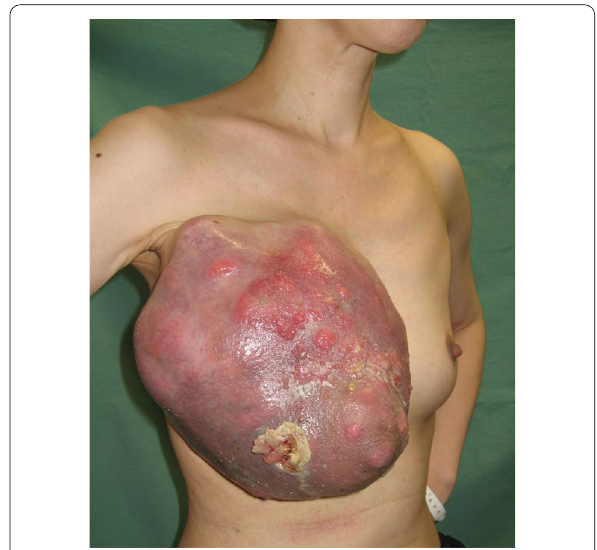
Fig. 1 Huge phyllodes tumor with ulceration in the right breast